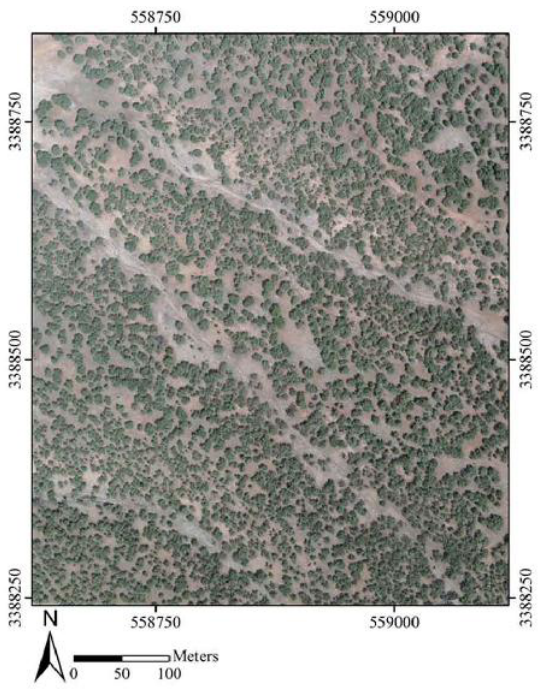
Figure 4. The UCD imagery of the study area.